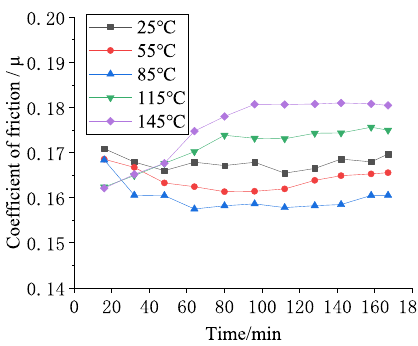
Fig. 5. Change process of friction coef fi